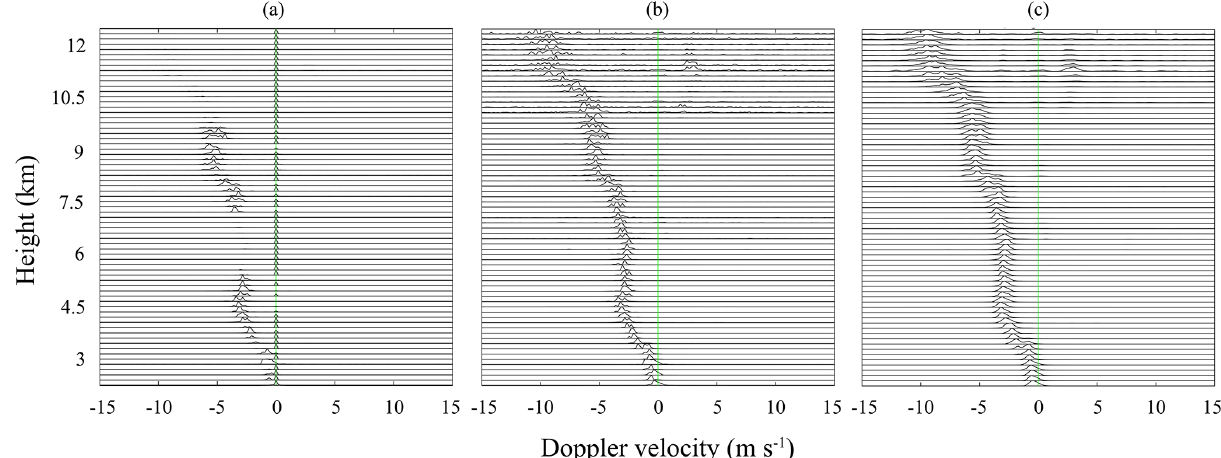
Figure 6. Comparison of the original (a) , ground-clutter-suppressed (b) , and filtered (c) Doppler spectrum.